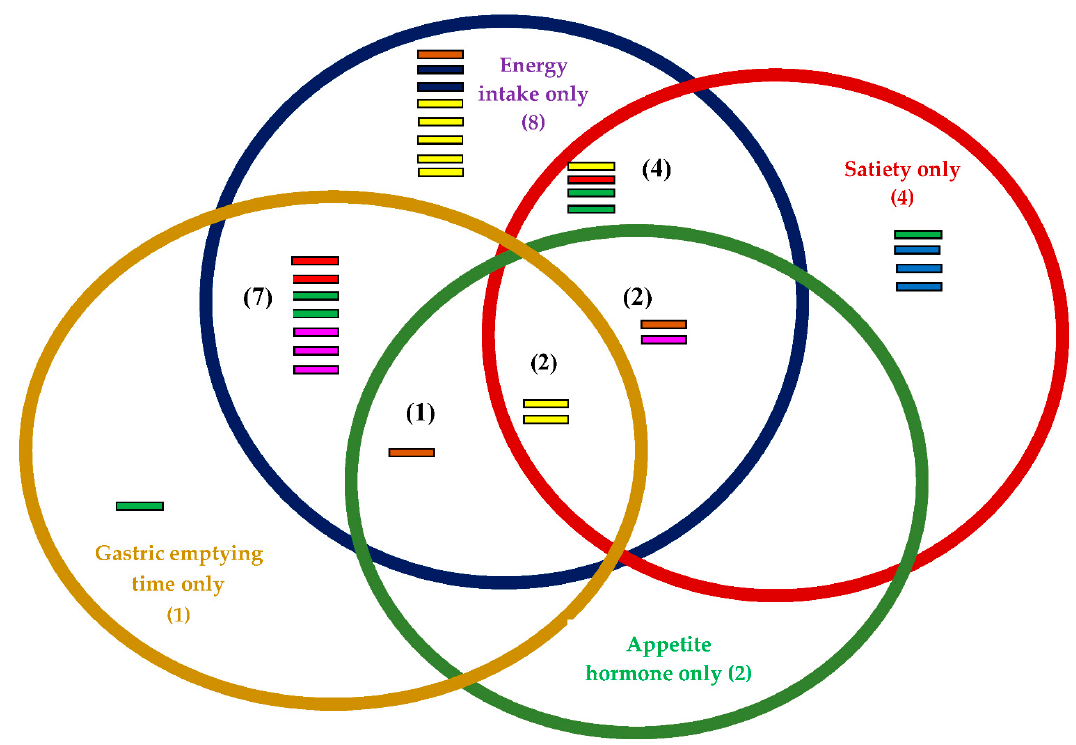
Figure 2. Outcome measure for each fibre: Energy intake (blue circle) = 24; Satiety (red circle) = 12; Gastric emptying time (yellow circle) = 11; Appetite hormone (green circle) = 7;